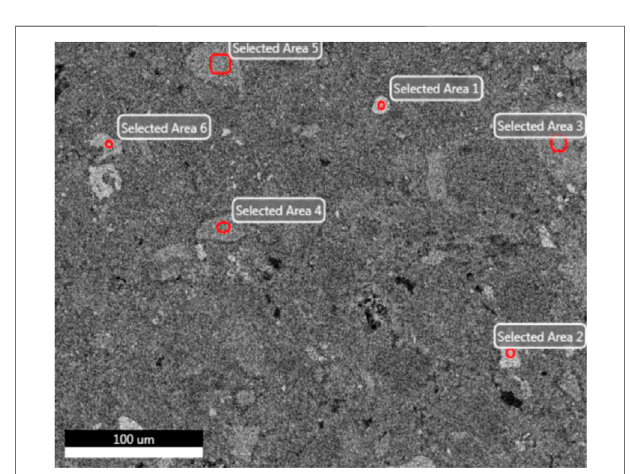
FIGURE 9 | EDS detection dots (300 × ).